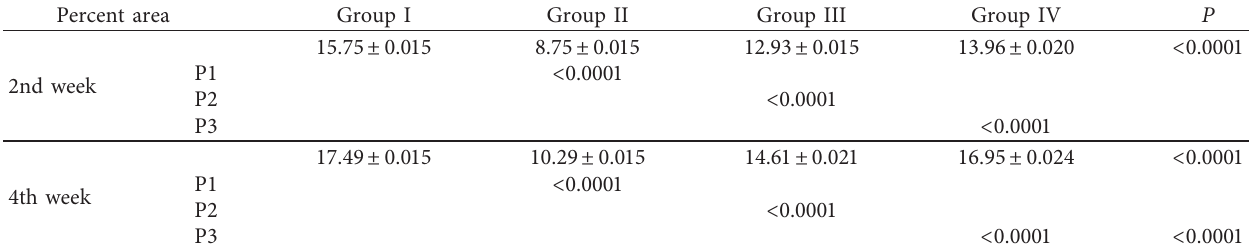
Table 2: Mean ± SD for the collagen fiber area percentage at two examination periods.